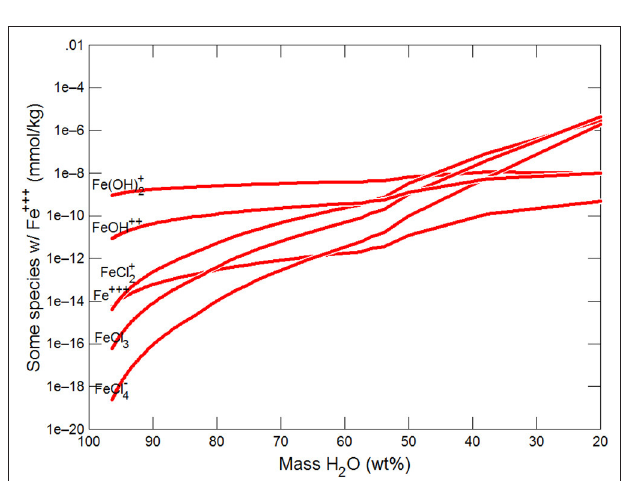
FIGURE 8 | Variations in pCO 2 during freezing of seawater.